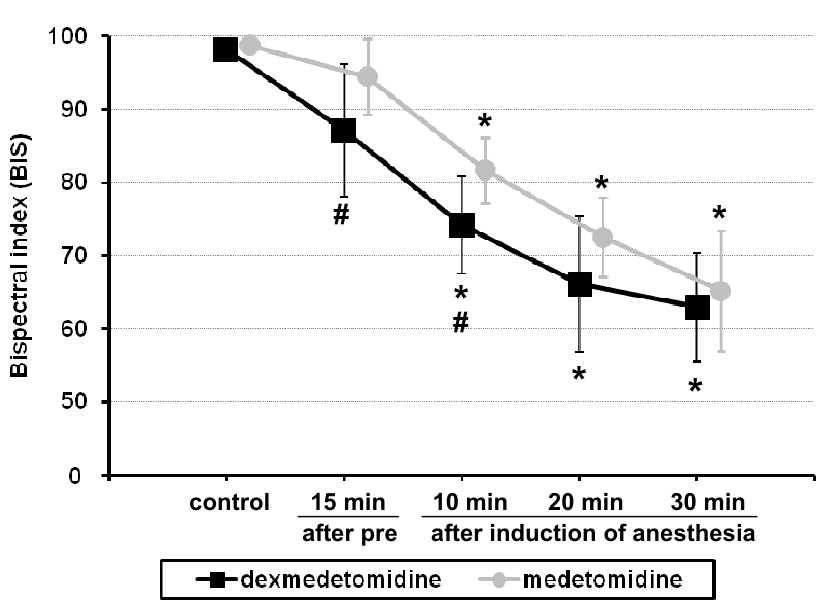
FIGURE 2 – Bispectral Index (BIS) of groups treated with dexmedetomidine (DEX) or medetomidine (MED) at the five time points * P<0.05: versus control at the same group; # P<0.05: DEX versus MED at the same time of observation; values as mean ± standard deviation; pre = preanesthetic medication.